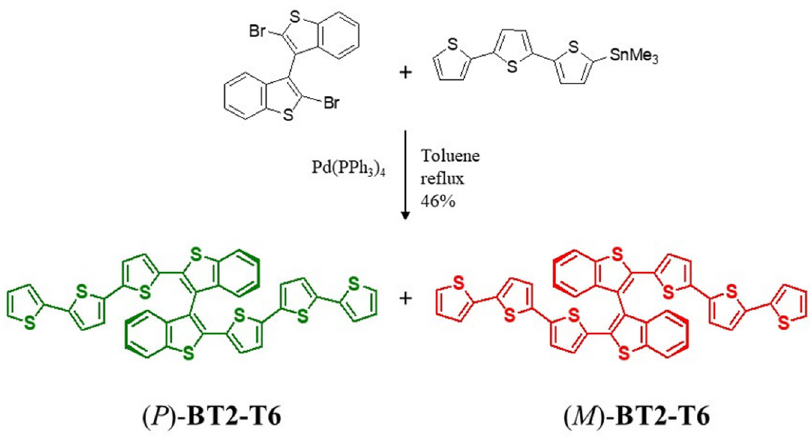
Figure 1. The final step in the synthesis of the racemates of BT2 – T6 . Finally, the chiroptical properties of the enantiomers collected in the optimized HPLC conditions were exhaustively determined and correlated with those of the parent BT2 – T4 to determine the absolute configuration of the enantiopure